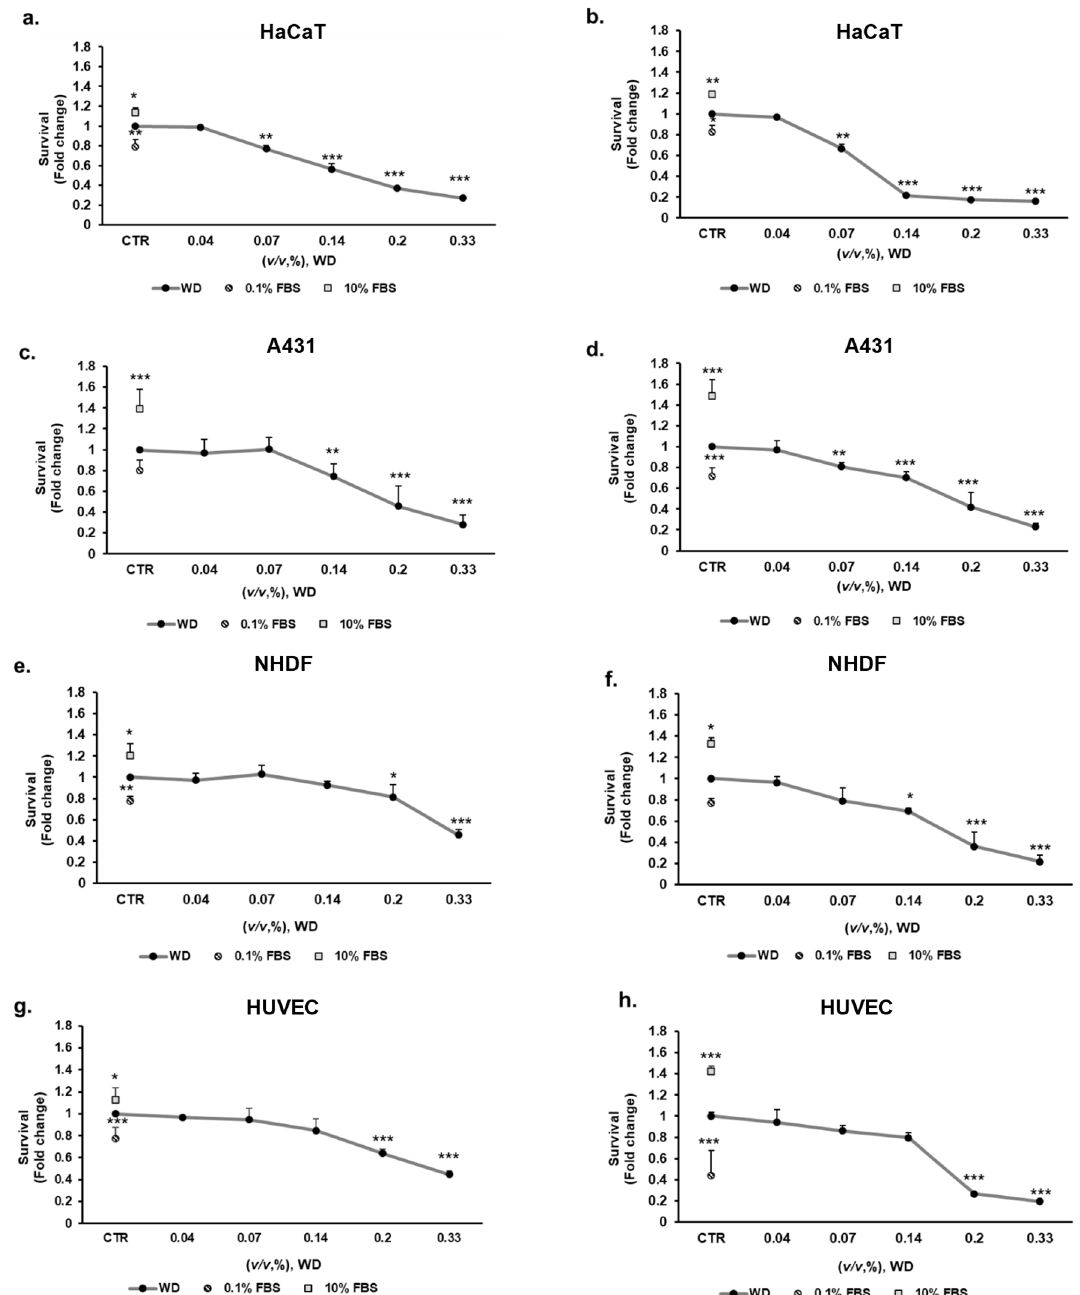
Figure 3. Effect of WD on cell viability, evaluated by the MTT test: prolonged exposure. Keratinocytes HaCaT ( a , b ), model of mucosal epithelial cells A431 ( c , d ), fibroblasts NHDF ( e , f ), and endothelial cells HUVEC ( g , h ), were exposed to increasing concentrations of WD (0.04–0.33%, v / v ), under experimental condition of medium with 1% FBS. Viability was measured after 24 h ( a , c , e , g ) and 48 h ( b , d , f , h ) of incubation by MTT test. Survival data were calculated as 540 nm relative absorbance/well. Data in the graphs are reported as fold change (means ± SD), giving 100% to the control condition (CTR: medium with 1 % serum). (n = 3). * p < 0.05, ** p < 0.01, *** p < 0.001 vs. untreated cells.